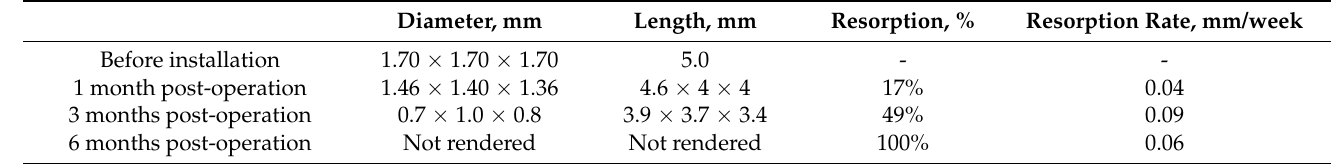
Figure 13. ( a,b ) Image of the femur of an animal 6 months after implantation (obtained using micro- CT). Only the holes for the implant placement were visualized; presumably, the implants had been completely resorbed. Table 1. Assessment of the levels of resorption of the